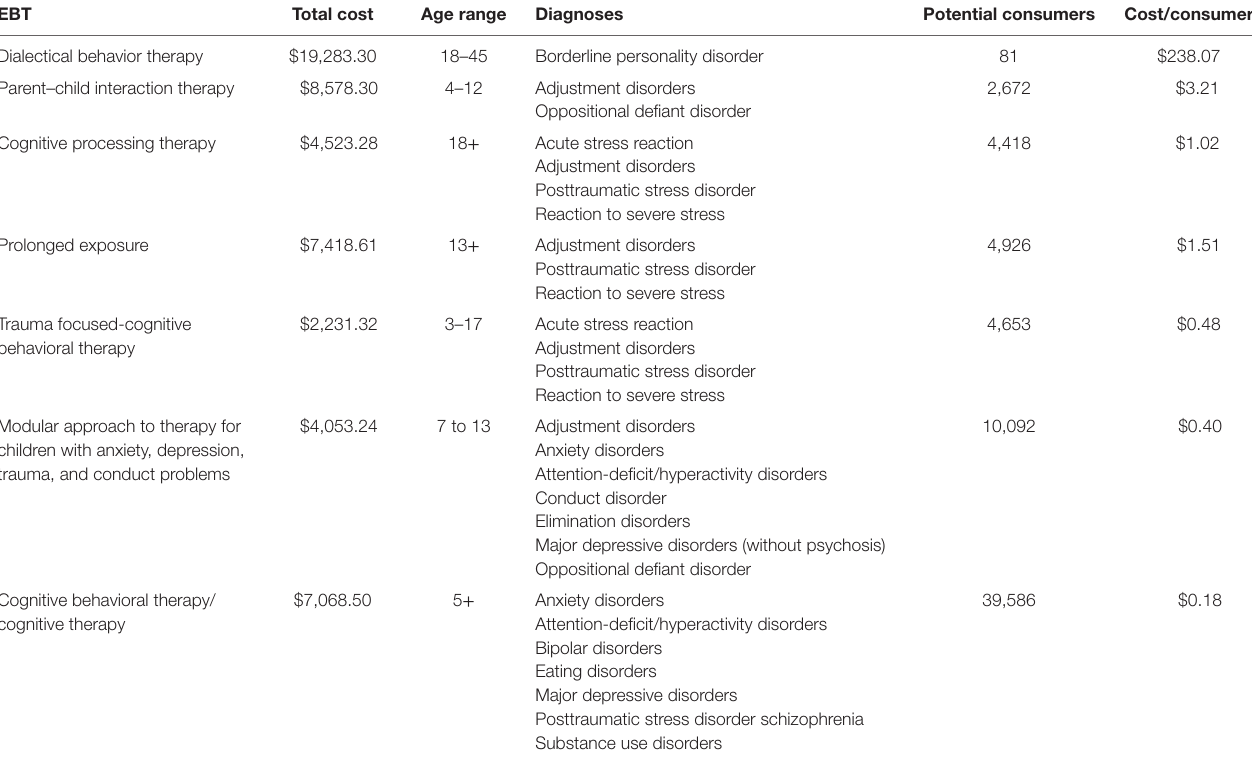
TaBle 3 | Evidence-based treatment (EBT) cost per